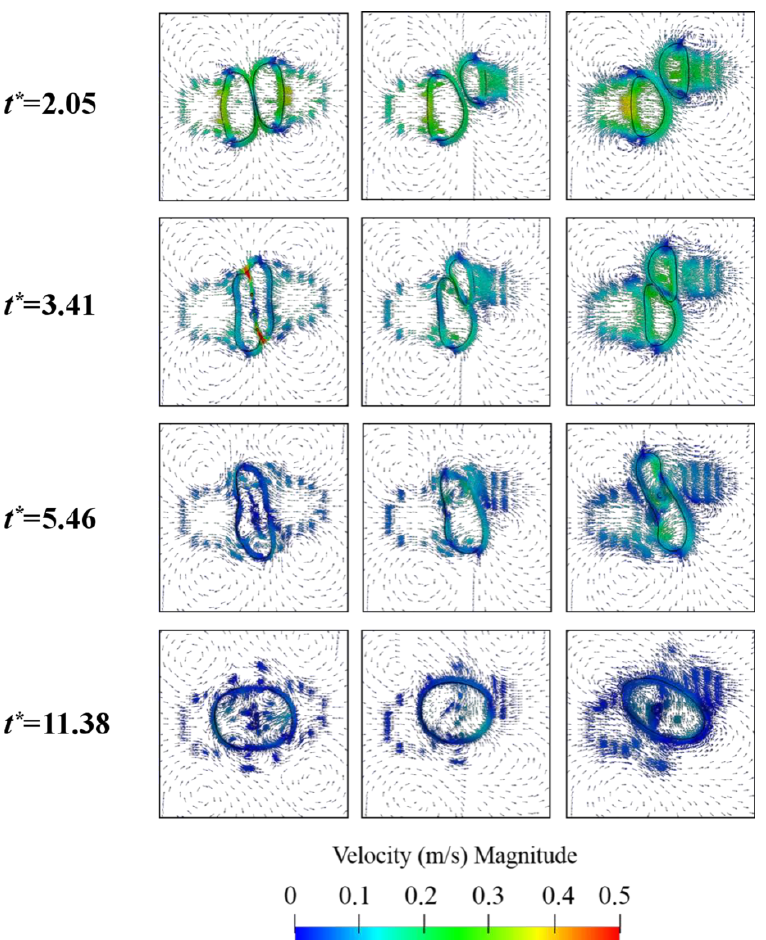
Figure 10. Evolution of the velocity field of the droplet coalescence process under different collision parameters. From left to right: B = 0.25, B = 0.5, B = 0.75 .